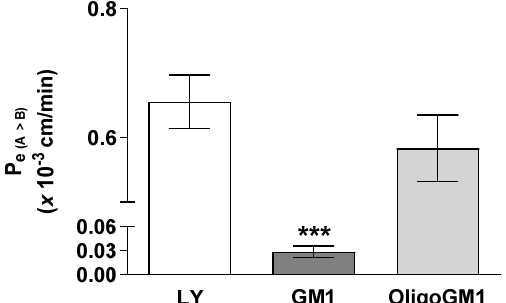
Figure 3. GM1 and OligoGM1 Pe coefficients through the hBLEC layer. Direct transport ‐ related Pe (A → B) ( × 10 − 3 cm / min) of 50 µ M OligoGM1, GM1, and LY after 60 min. Results are mean ± SEM from 4 independent experiments (*** p < 0.01 vs. LY and OligoGM1, two-way ANOVA, n = 4) performed by examining a minimum of 3 wells for each condition.